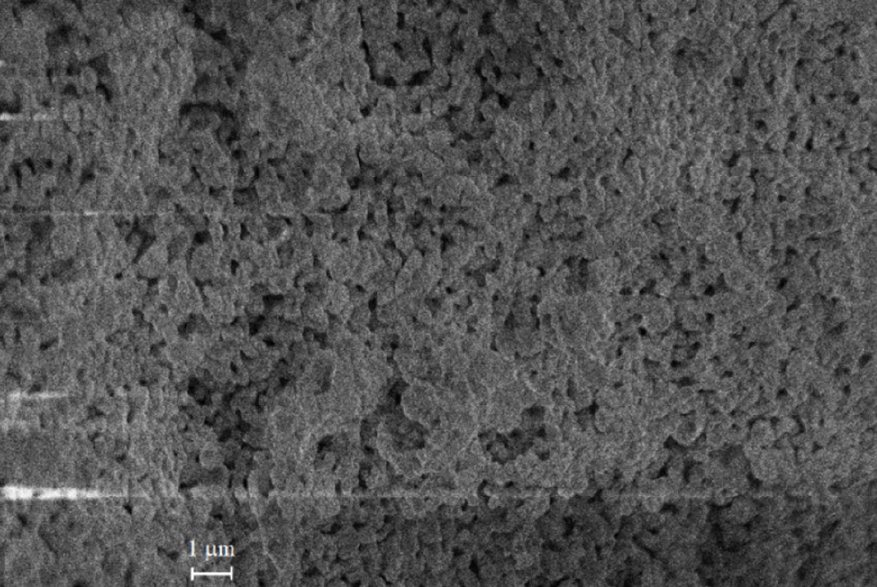
Figure 4. Scanning electron microscopy image of pressed LiNb 0.5 Ta 0.5 O 3 after impedance measure- ments performed at 820 °C.